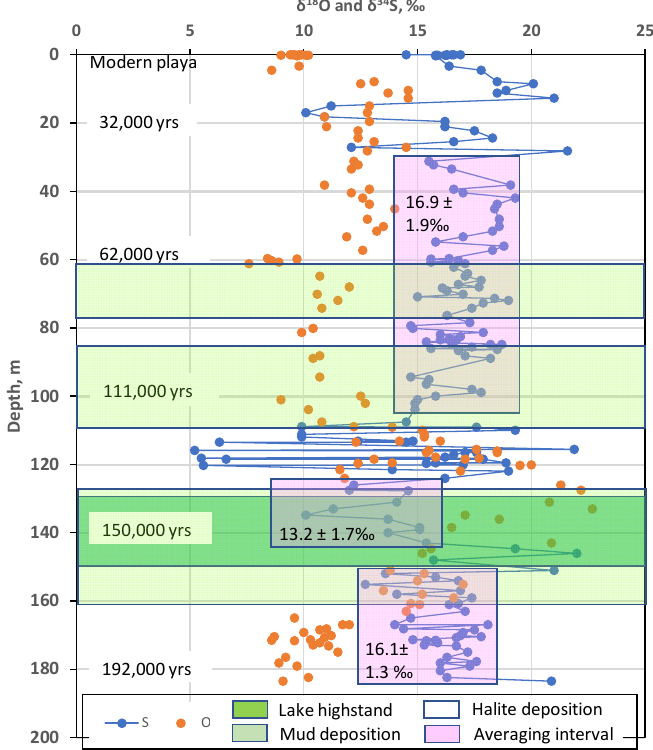
Figure 8. Values of δ 34 S and δ 18 O (sulfate) in drill-cuttings from Badwater, Death Valley, California as a function of depth below surface and sediment age. Data source, including paleoenvironmental interpretations [59].